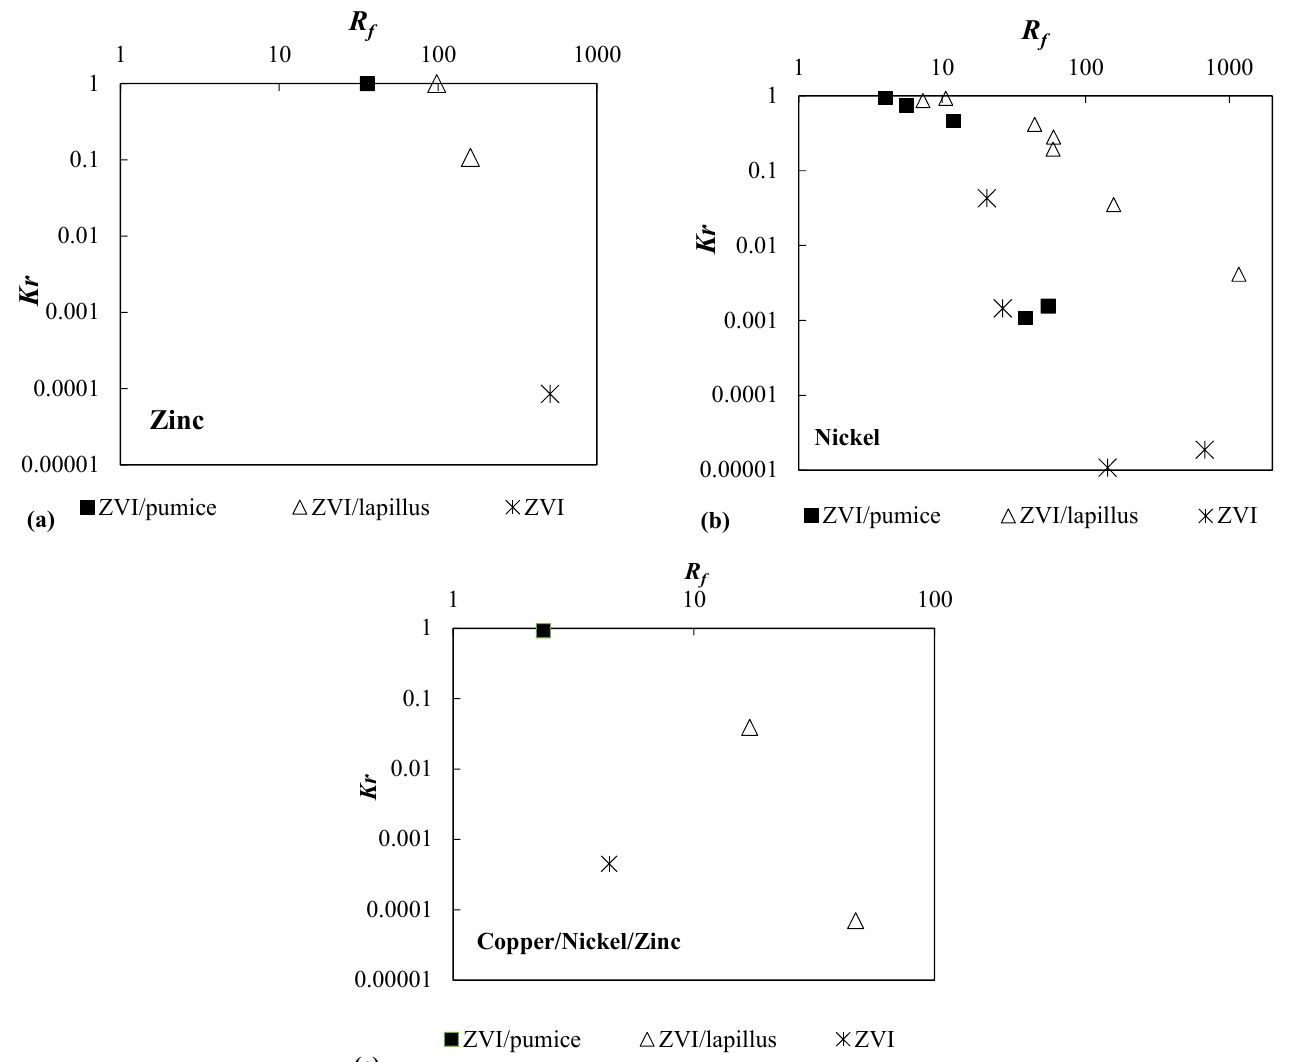
Figure 3. Kr vs. R f for granular reactive media permeated with ( a ) zinc, ( b ) nickel, and ( c ) cop- per/nickel/zinc.